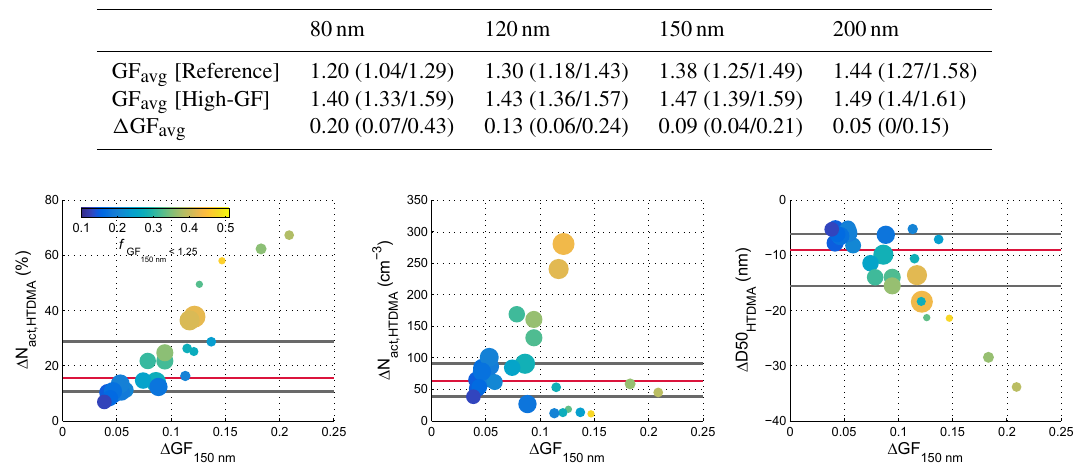
Table 2. Average GFs for reference and high hygroscopicity scenarios and their absolute deviation from each other. The values shown in the parentheses correspond to the minimum and maximum values. The GFs for D p = 80, 120 and 150nm originate from direct measurements, whereas the data for D p = 200nm is obtained via extrapolation.